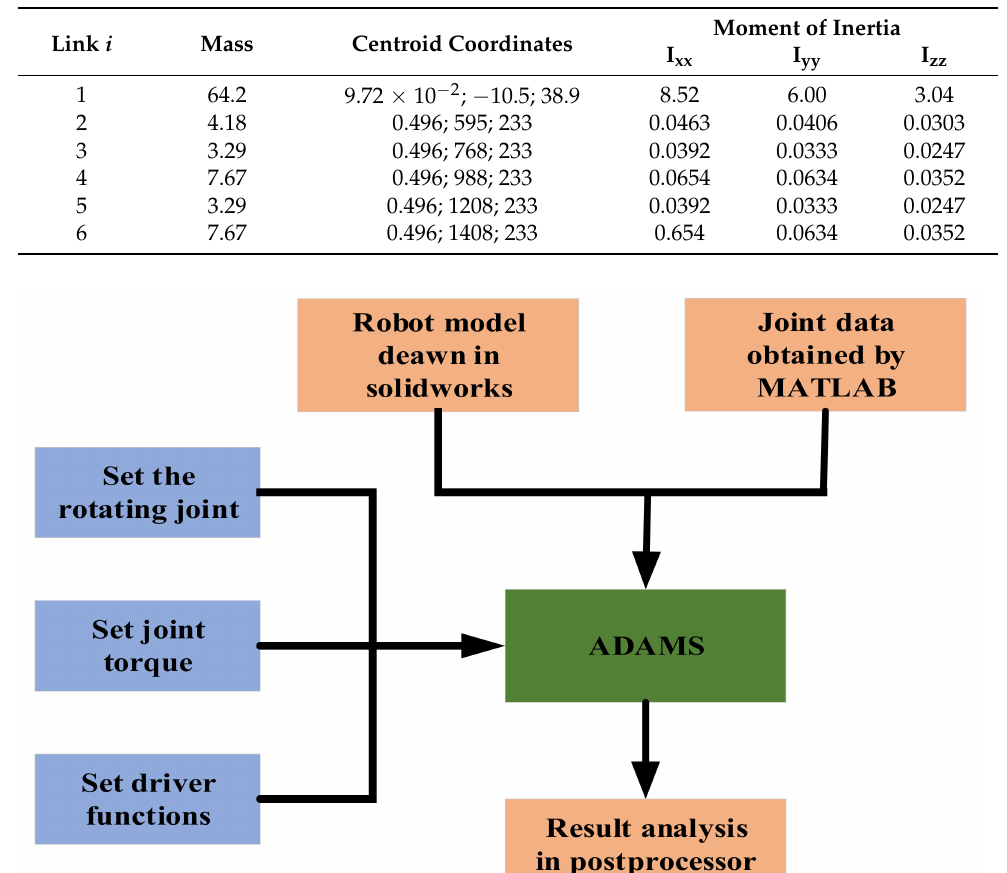
Table 3. Dynamic parameters of the dual-arm robot model in Adams.